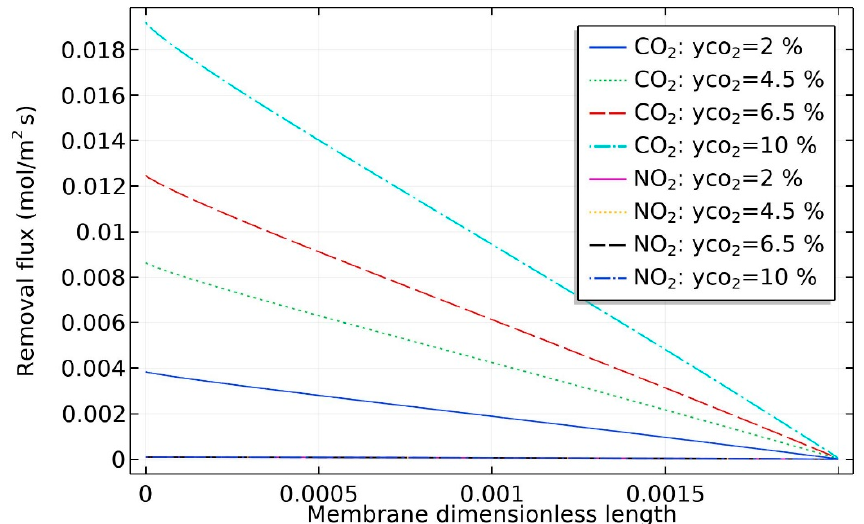
Figure 6. Impact of the inlet CO 2 feed concentration on the NO 2 and CO 2 capture flux along the membrane length at other fixed parameters (aqueous NaOH: 0.5 M; velocity of solvent: 0.05 m/s; gas velocity: 2.11 m/s; gas composition: (2% to 10%) CO 2 ; 300 ppm NO 2 ; the balance is N 2 ).